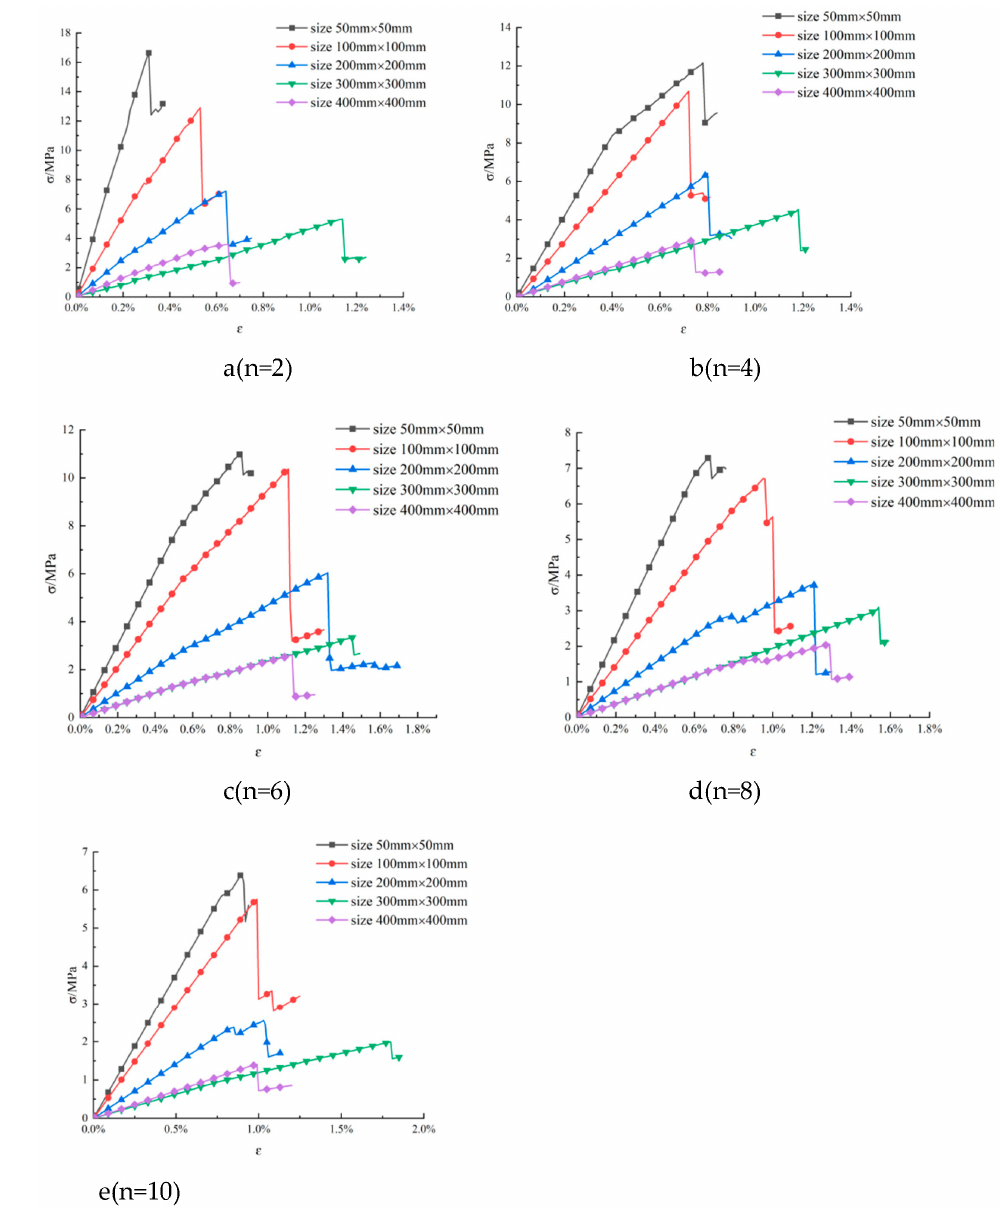
Figure 8. Stress–strain curves with different sizes and NPJs.